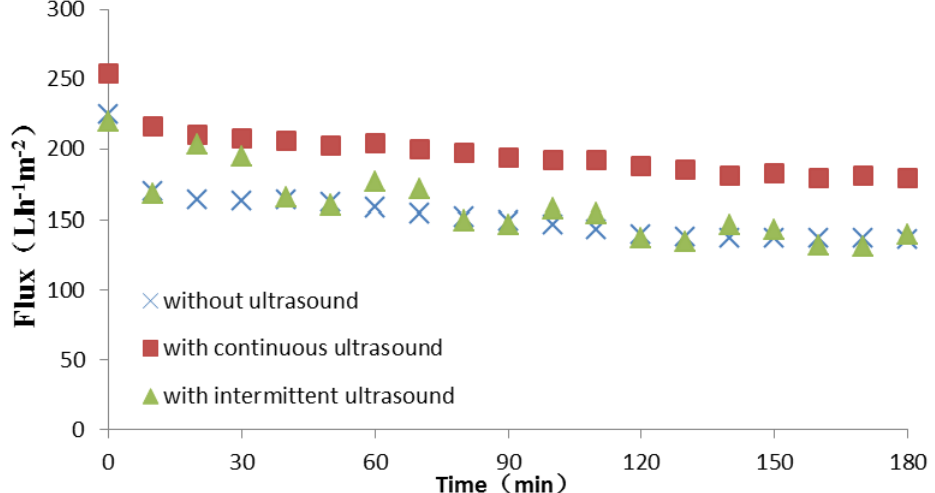
Figure 5. Influence of ultrasound on Tongbi liquor permeate